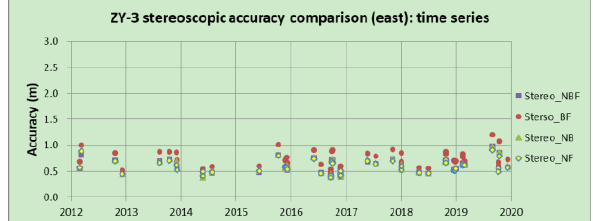
Figure 19. ZY-3 stereoscopic accuracy comparison (east) Num=47